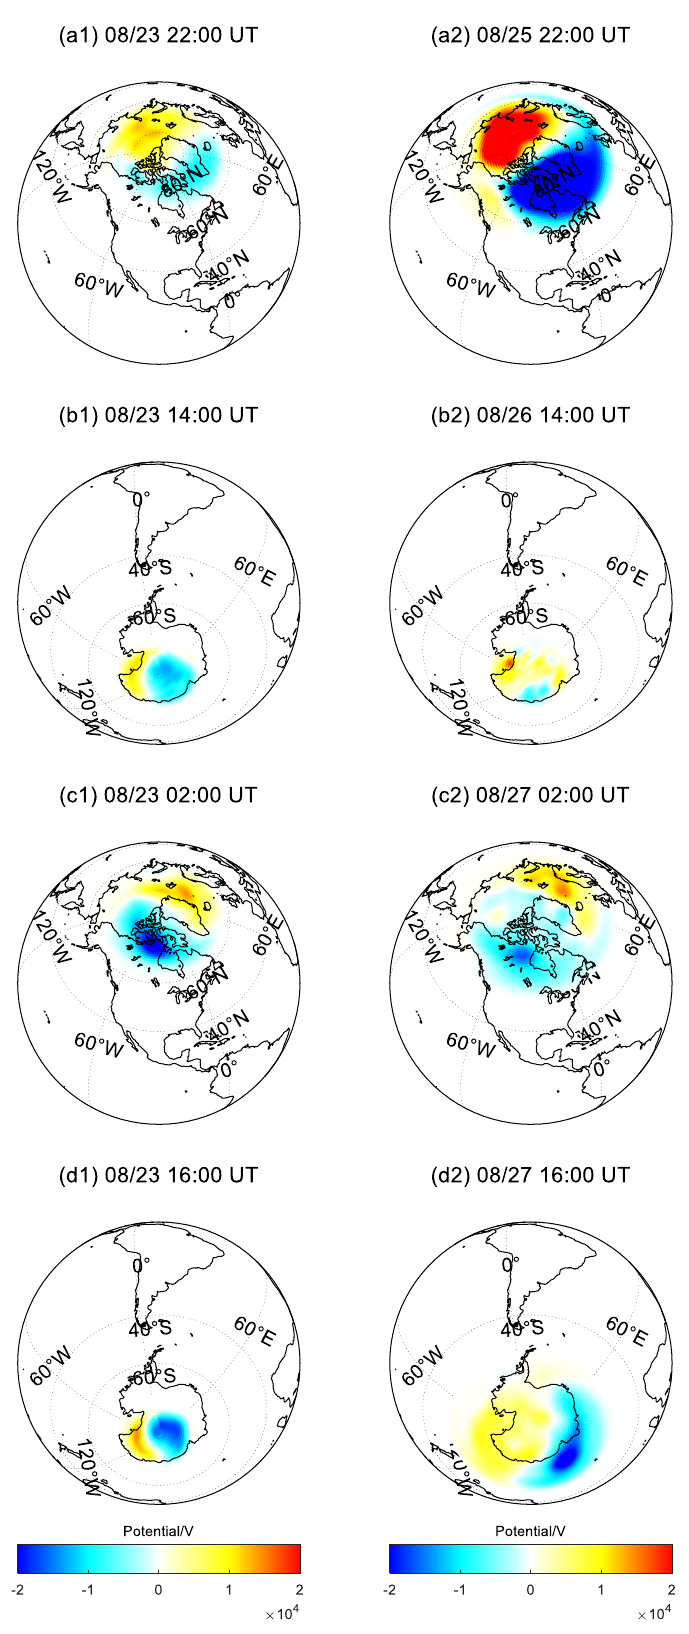
Figure 12. Comparison of polar cap potential map between quiet day ( left column) and storm days ( right column).